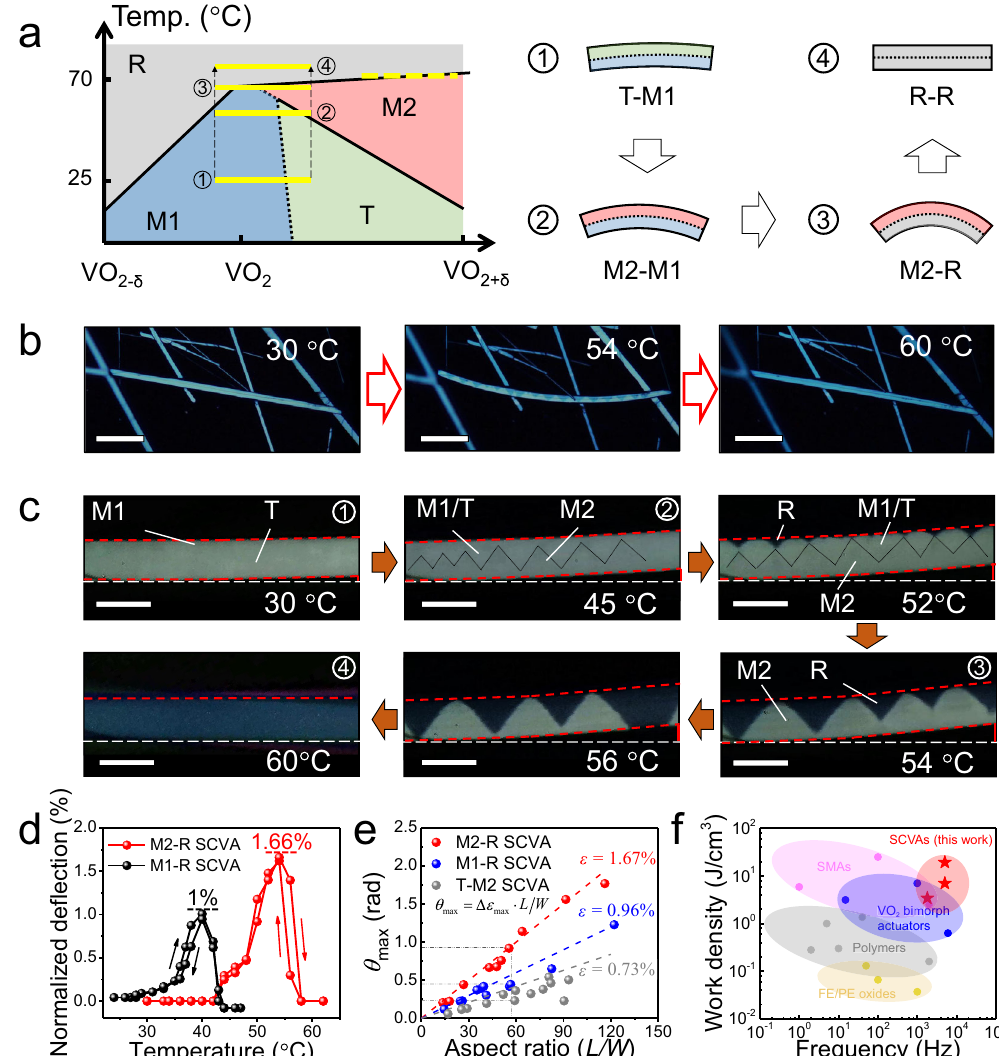
Fig. 4 W-doped SCVA with superior actuation performance. a Working mechanism for the W-doped M2-R type SCVA with the array of yellow gradient bars tracing the actuation process upon heating (top-right fi gures). b Optical images of a W-doped SCVA at increasing temperature (scale bars are 40 μ m). c Temperature-dependent optical images of another SCVA showing a clear domain evolution process (scale bars are 5 μ m), where black dash lines are plotted at the positions of domain walls between M2 and M1/T domains. The numbers at the top right-hand corner of the images correspond to the schematic images in Fig. 4a. d Temperature-dependent de fl ection of a M2-R type SCVA compared to a M1-R type SCVA. e Plots of θ max of SCVAs versus their L / W ratios. The colored dash-lines are theoretical θ max − L/W plots of SCVAs utilizing the unidirectional strain ( ε ) of VO 2 across the phase transitions, ε = 1.67% for M2-R transition, ε = 0.96% for M1-R transition, and ε = 0.73% for T-M2 transition. f Actuation frequency and volumetric work density for various actuator systems, including ferroelectric/piezoelectric (FE/PE) oxides, polymers, shape memory alloys (SMAs), VO 2 bimorph actuators, and